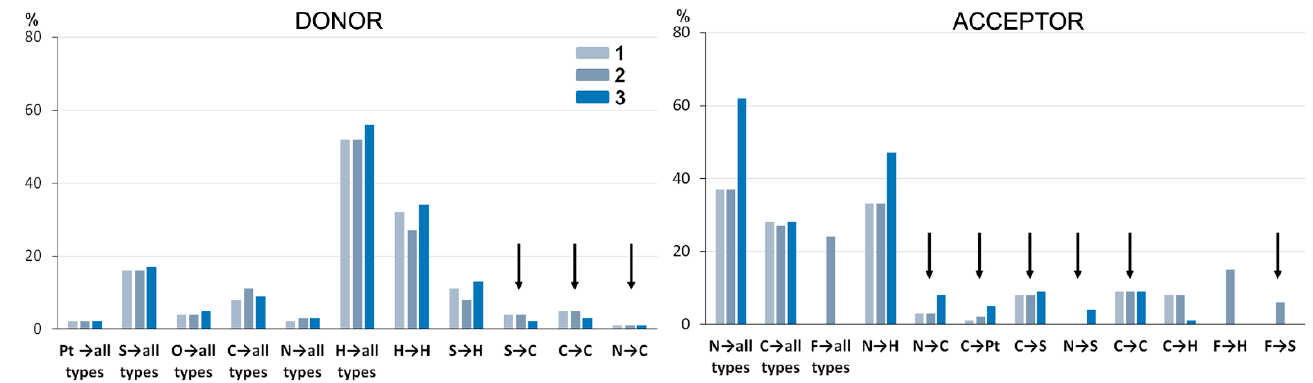
Figure 4. Percentage contributions of the various intermolecular contacts exchanged by the donor moiety and by the acceptor moiety with the surrounding environment for complexes 1 – 3 are reported as colored bars. The arrows indicate interactions occurring between atoms that are part of planar and electronically delocalized systems.